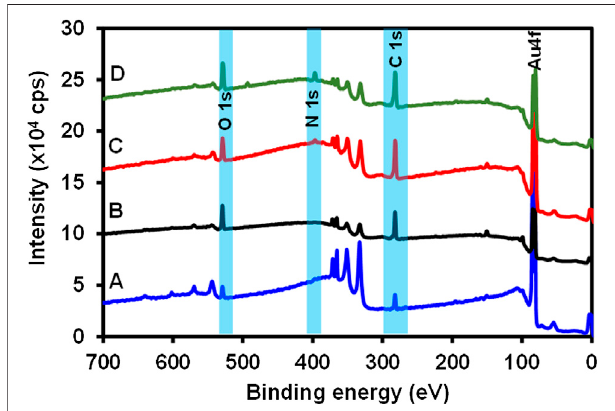
FIGURE 2 | The survey spectra of (A) bare Au, (B) Au-MBA SAM, (C) Au-MBA-APBA SAM, and (D) Au-MBA-APBA-mAb/glucose.